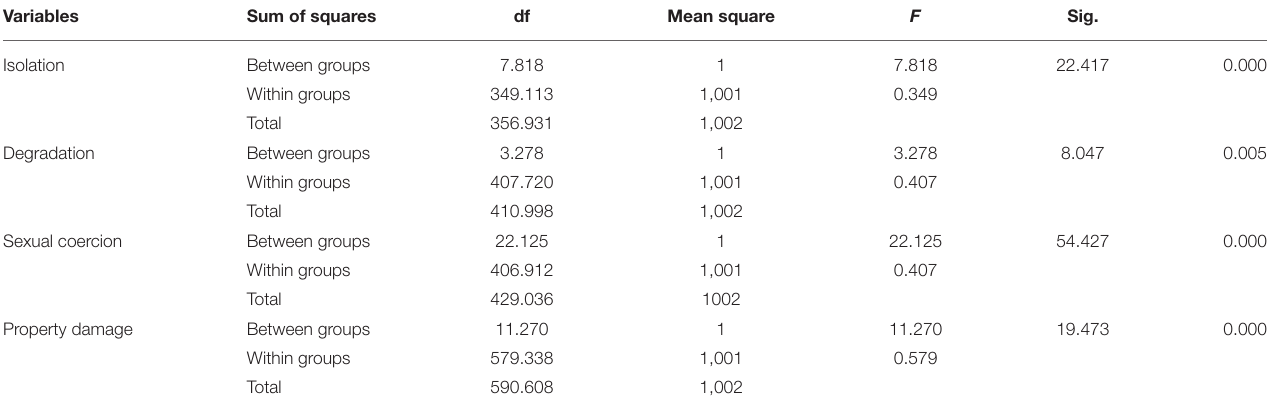
TABLE 4 | Analysis of variance for emotional abuse domains between rural and urban areas. Variables